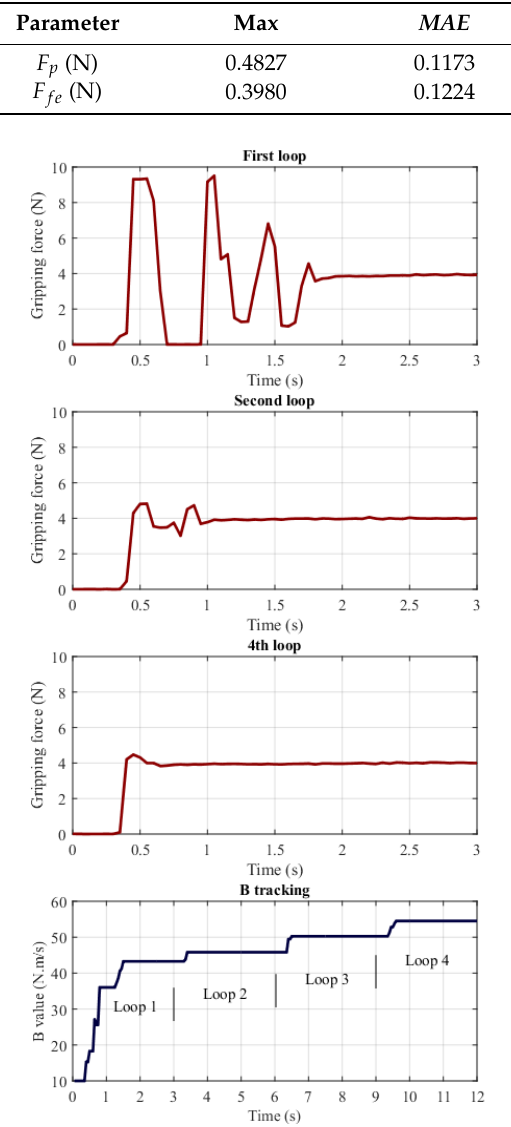
Figure 10. The tracking force and B value through several loops in the experiment.